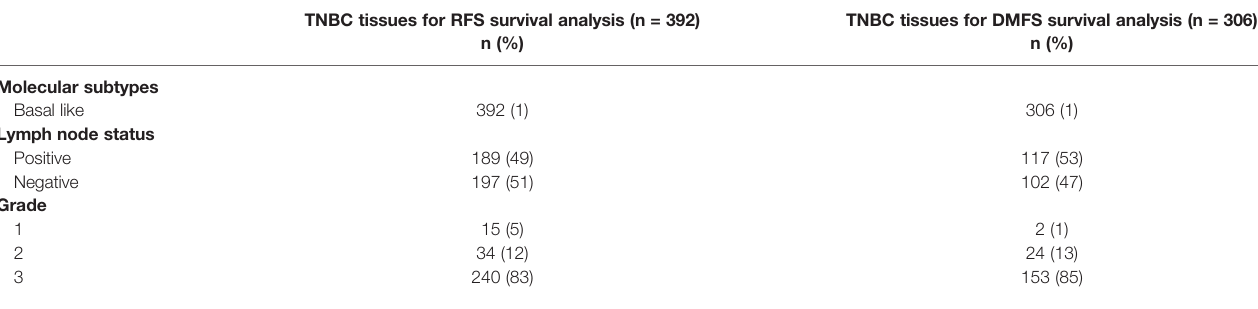
TABLE 1 | Description of validation data set from KM plotter for RFS and DMFS analysis of IGLC2. TNBC tissues for RFS survival analysis (n = 392) n